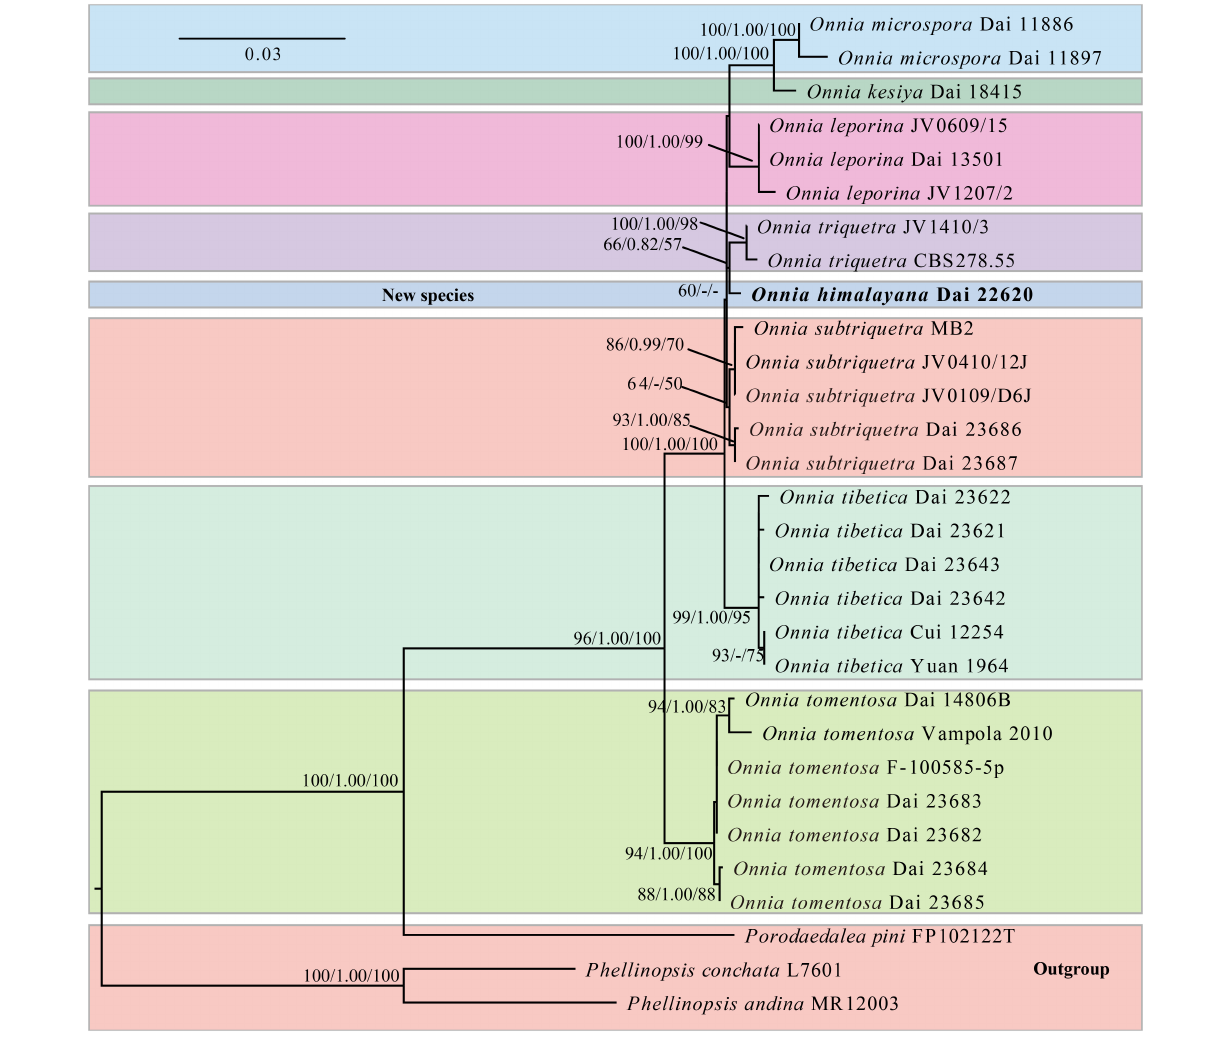
FIGURE 1 | Maximum likelihood (ML) phylogenetic tree of Onnia based on ITS and LSU rDNA sequences, with Porodaedalea pini , Phellinopsis conchata, and P . andina as outgroups. ML bootstrap values ( ≥ 50%)/maximum parsimony (MP) bootstrap values ( ≥ 50%)/Bayesian inference (BI) posterior probabilities ( ≥ 0.8) of each clade are indicated along branches. A scale bar in the upper left indicates substitutions per